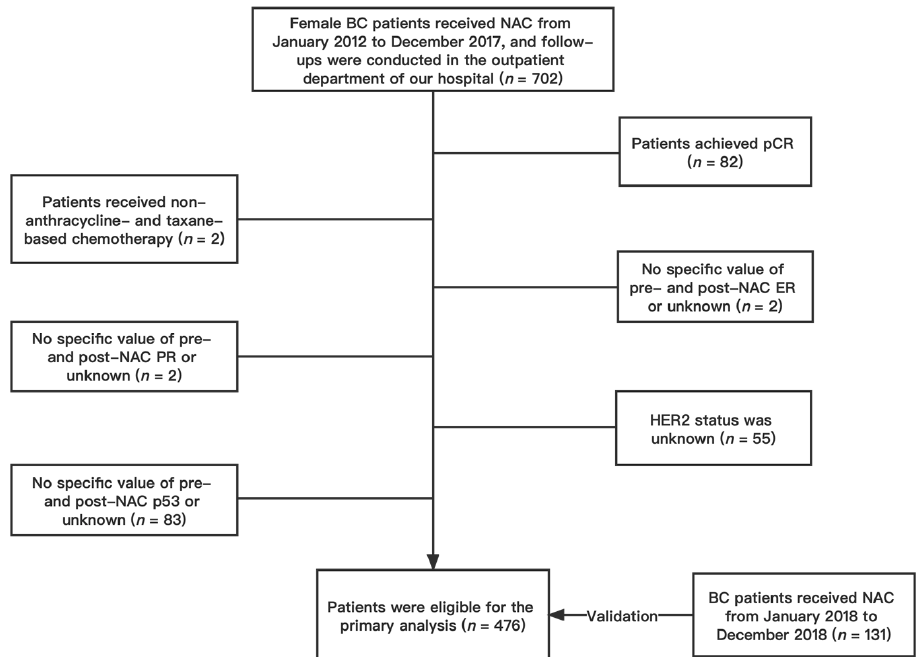
Figure 1. Flow chart of patient selection. Abbreviations: BC, breast cancer; NAC, neoadjuvant chemotherapy; pCR, pathologic complete response; ER estrogen receptor; PR progesterone receptor; HER2 human epidermal growth factor receptor 2.